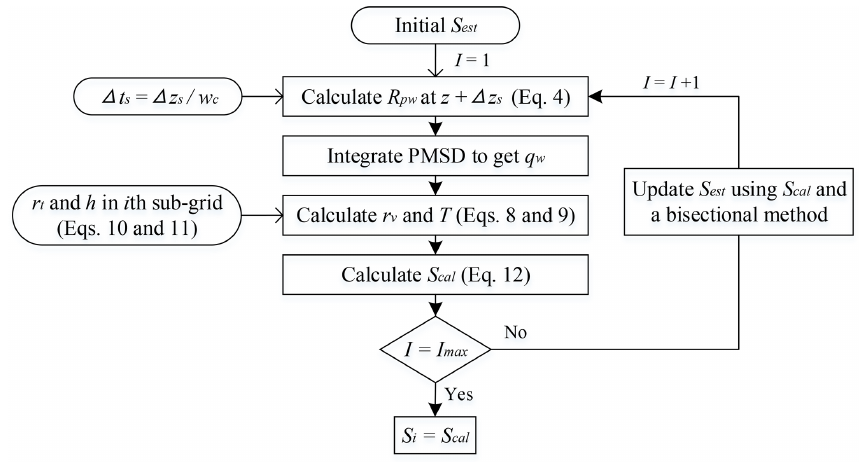
Figure 2. The flow chart of the iterative calculation for the subgrid supersaturation S i . I is the number of iterations. PMSD is the particle mass-size distribution. Total water mass mixing ratio, r t , and liquid water static energy, h , are